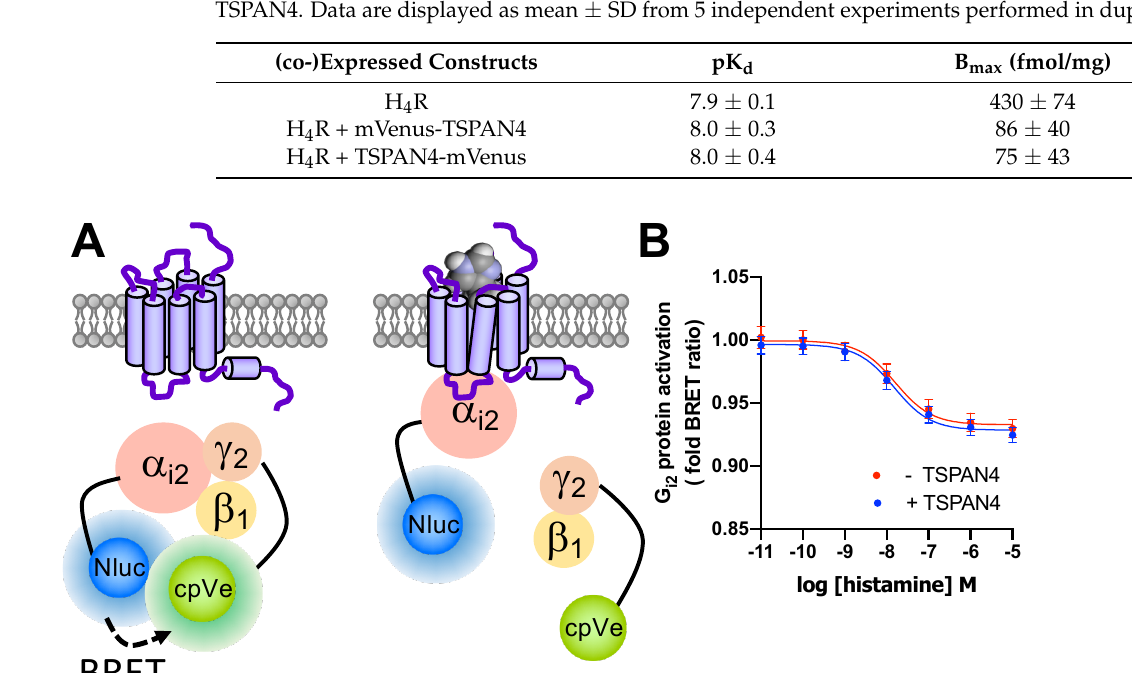
Figure 6. Detection of G α i protein activity in HEK293T cells by BRET-based G protein biosensor. ( A ) Fusion of Nluc to G α i2 subunit and cpVenus to G γ subunit allows BRET detection of the heterotrimeric G protein complex. Agonist binding to the H 4 R leads to activation and dissociation of heterotrimeric G proteins, resulting in reduced BRET signal. ( B ) BRET measurements in HEK293T cells transiently co-expressing HA-H 4 R and G protein biosensor (red trace) or HA-H 4 R, V2-TSPAN4 and G protein biosensor (blue trace), upon stimulation with histamine for 20 min. Data are displayed as mean ± SEM from 3 independent experiments performed in